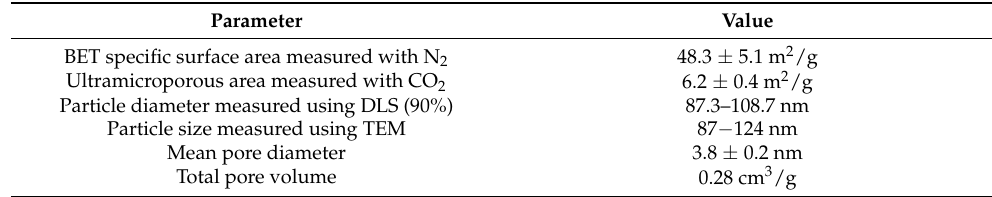
Table 2. Characterization of nanocellulose isolated from banana